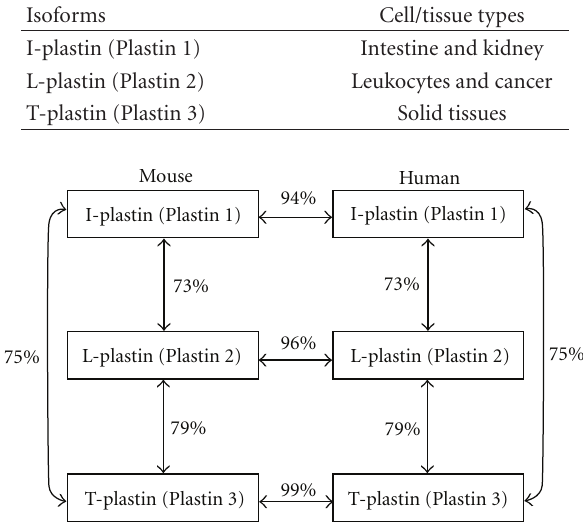
Figure 1: Human and mouse plastin isoforms. The homology bet- ween the amino acid sequences of these isoforms is showed.